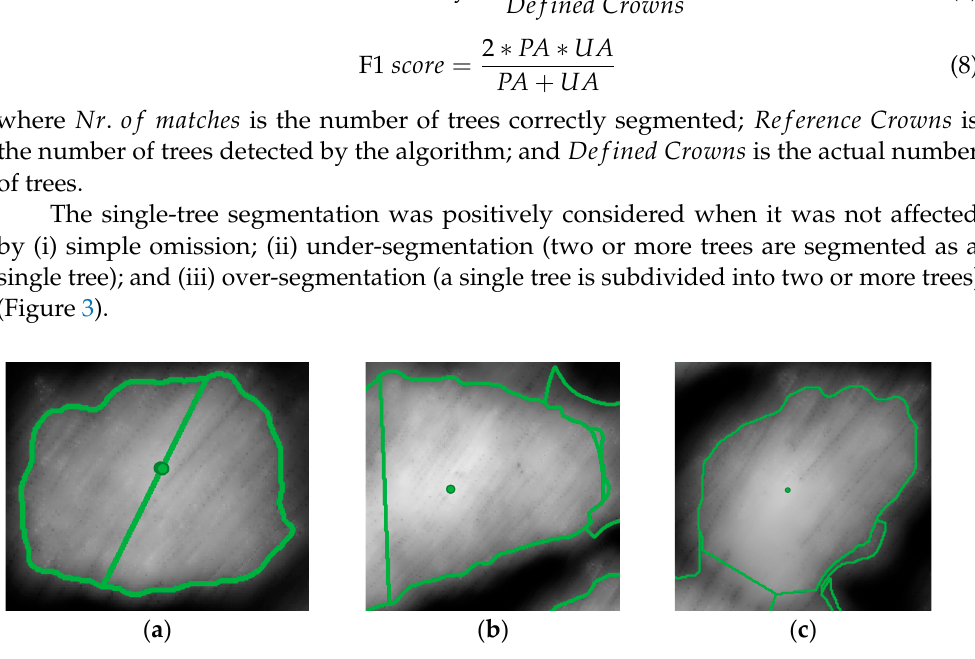
Figure 3. Example of the segmentation outcomes. ( a ) Over segmentation; ( b ) under segmentation; ( c ) correct segmentation. The layer shown is the CHM in grey scale.